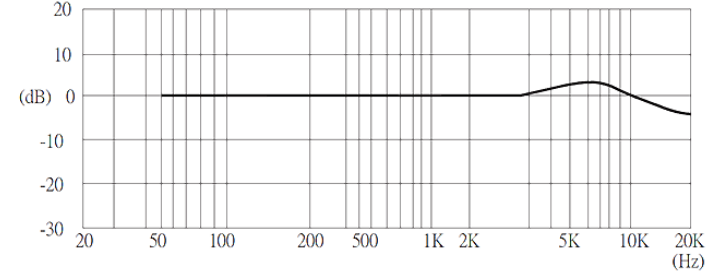
Figure 2. Frequency response curve of